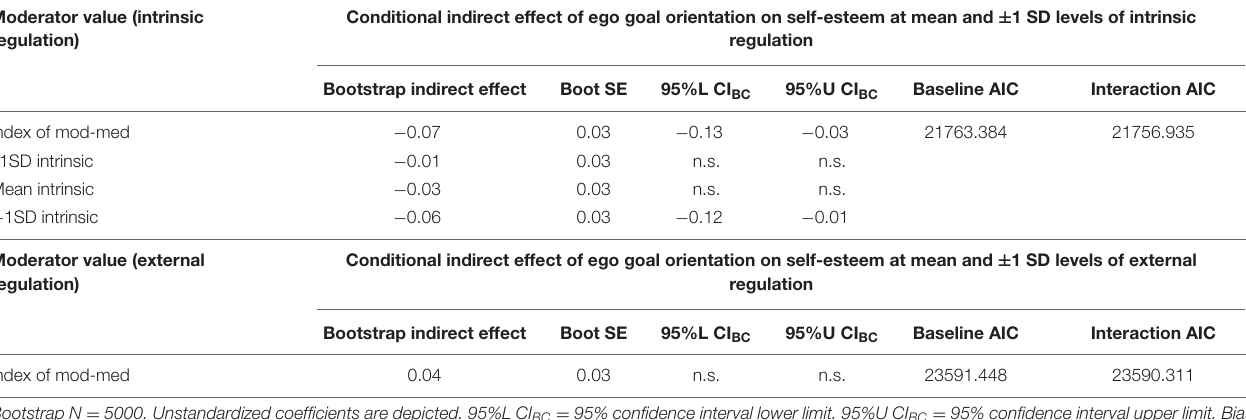
TABLE 5 | Conditional indirect effects models with ego goal